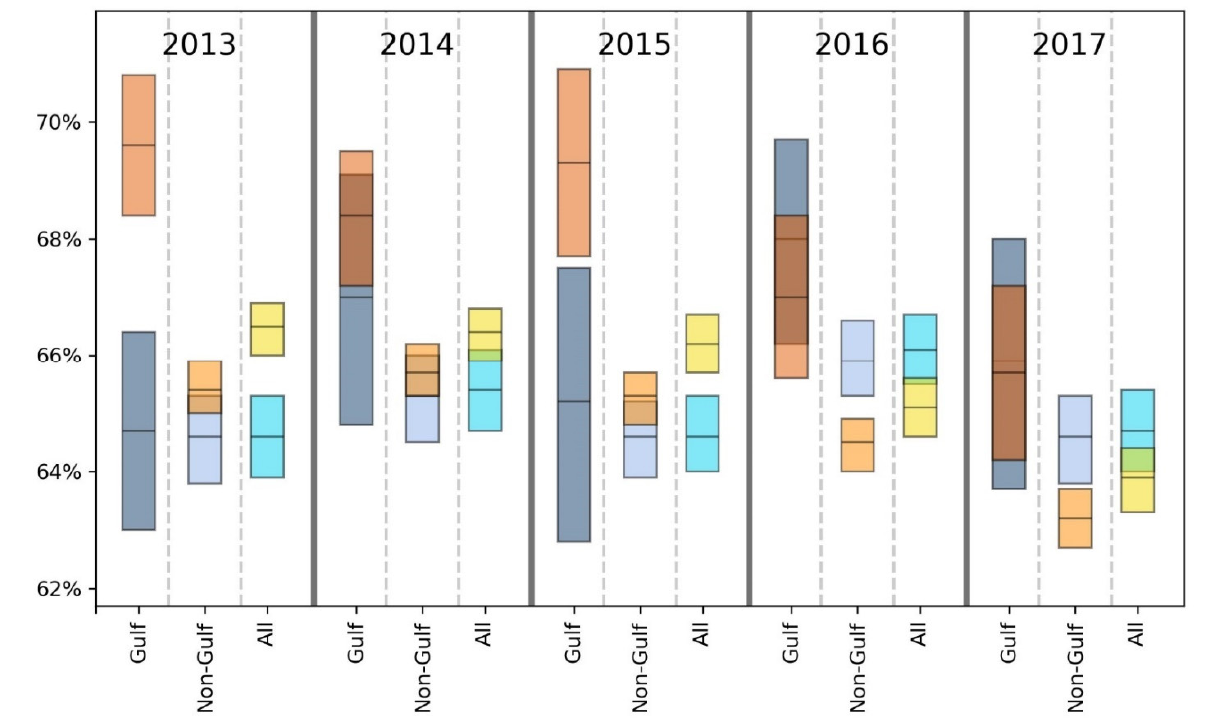
Figure 4. Comparison of mean (black line across bar) and 95% confidence intervals for percentages of Gulf and non-Gulf MMSA respondents reporting zero mentally unhealthy days out of the last 30. Colors denote the following: dark blue = coastal Gulf, light blue = coastal non-Gulf, dark orange = non-coastal Gulf, light orange = non-coastal non-Gulf, bright blue = all coastal, yellow = all non-coastal.